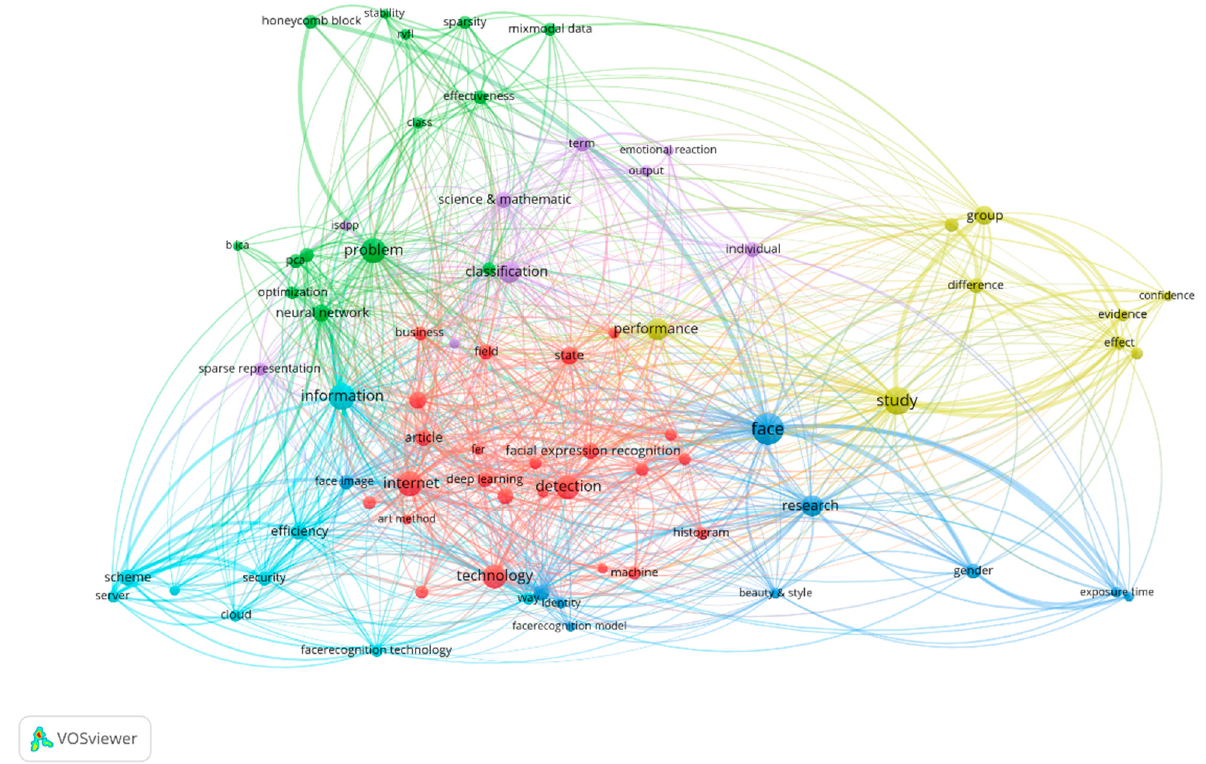
Figure 2. VOS Viewer representation of Title, Keywords and Abstract. The main four clusters depicted from VOS Viewer representation within Figure 2, are: Blue—illustrating key features of FR such as face, gender, identity, exposure time, face image, FR